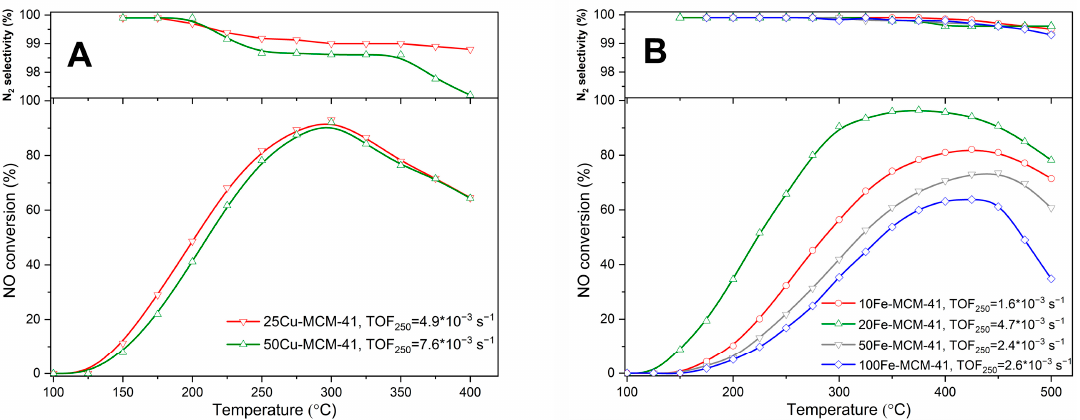
Figure 9. Temperature dependence of NO conversion and N 2 selectivity in SCR of NO with NH 3 for spherical MCM-41 modified with copper ( A ) and iron ( B